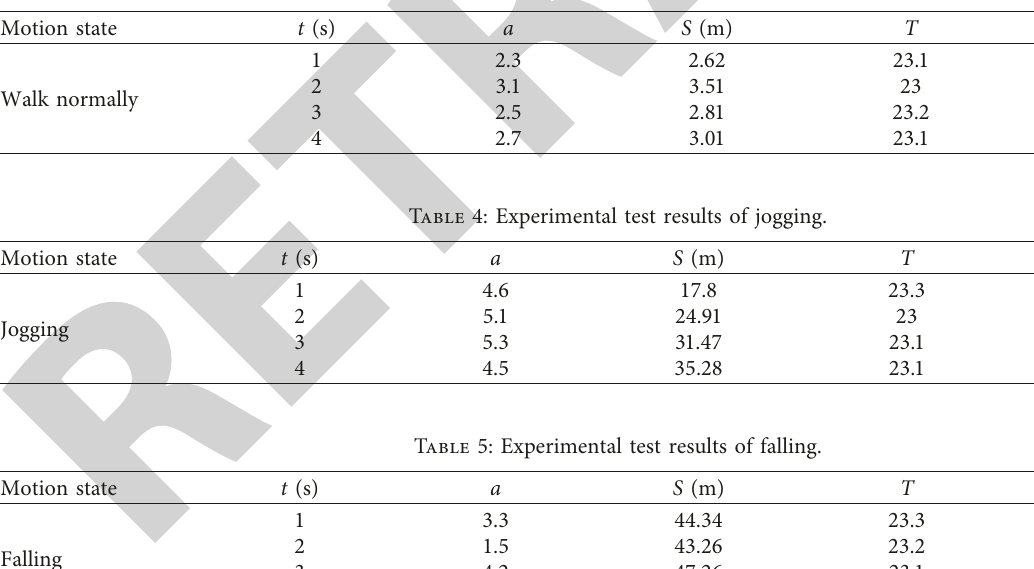
Figure 10: Changes in the body after a period of time. Table 3: Experimental test results of normal walking.